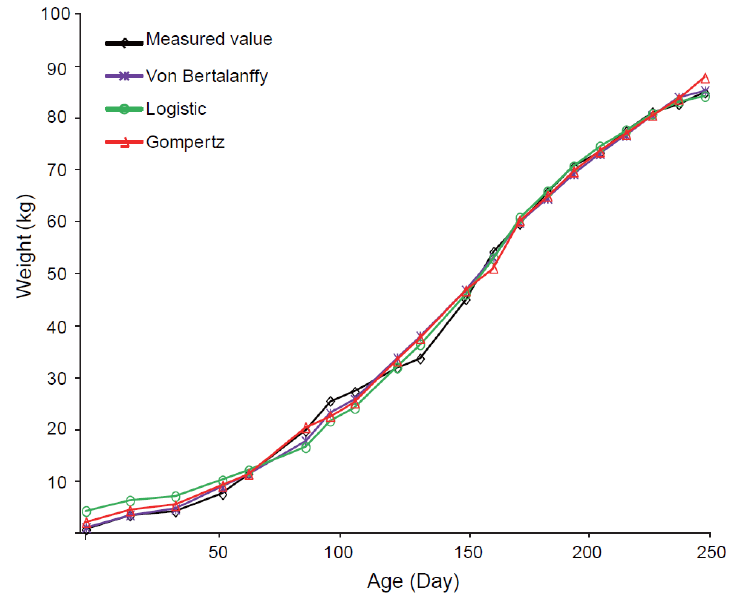
Figure 1. The actual growth curve and the fitting growth curve of different models of Liangshan